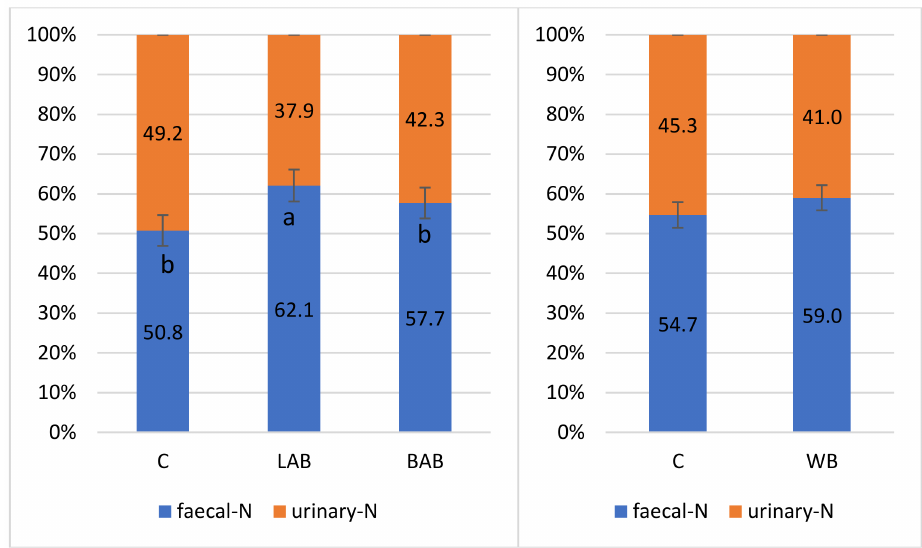
Figure 1. Treatment effects on the ratio of the faecal and urinary N. a,b means with different super- scripts are significantly different.